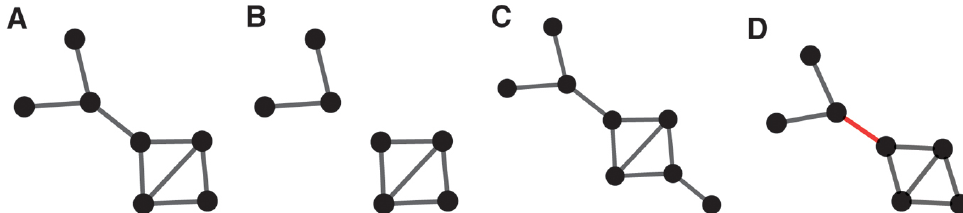
Figure 1: (A) – (C) Three graphs G edge. Fully conserved edges are colored gray while exception edges are colored